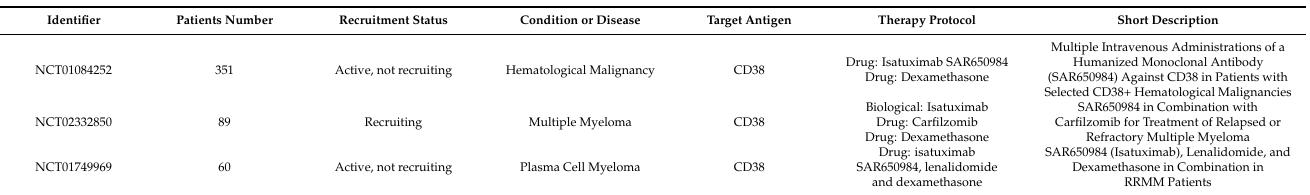
Table 4. Daratumumab and Isatuximab in Multiple Myeloma, NK- and T-cell lymphomas, and B-cell